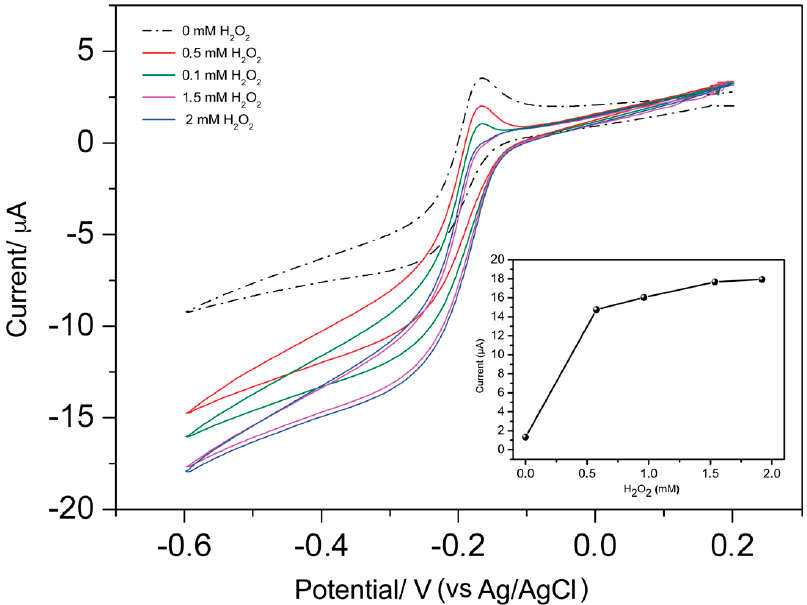
Figure 5. Cyclic voltammograms of the HRP-gliadin-NEA recorded in 0.1 mM MB in the presence of different concentrations of H 2 O 2 (0–2 mM). Scan rate, 50 mV s − 1 ; supporting electrolyte, 0.1 mM MB in